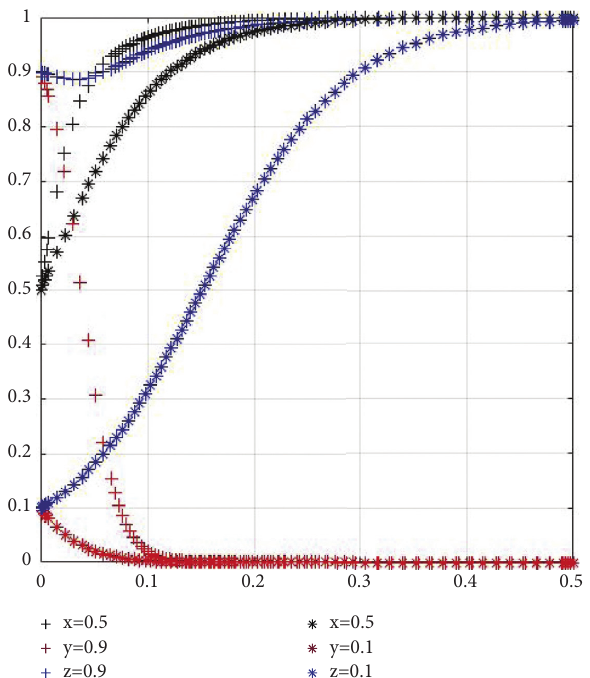
Figure 7: Participation willingness z remains unchanged, while x and y change simultaneously ( x � y � 0.1 ⟶ x � y � 0.9).